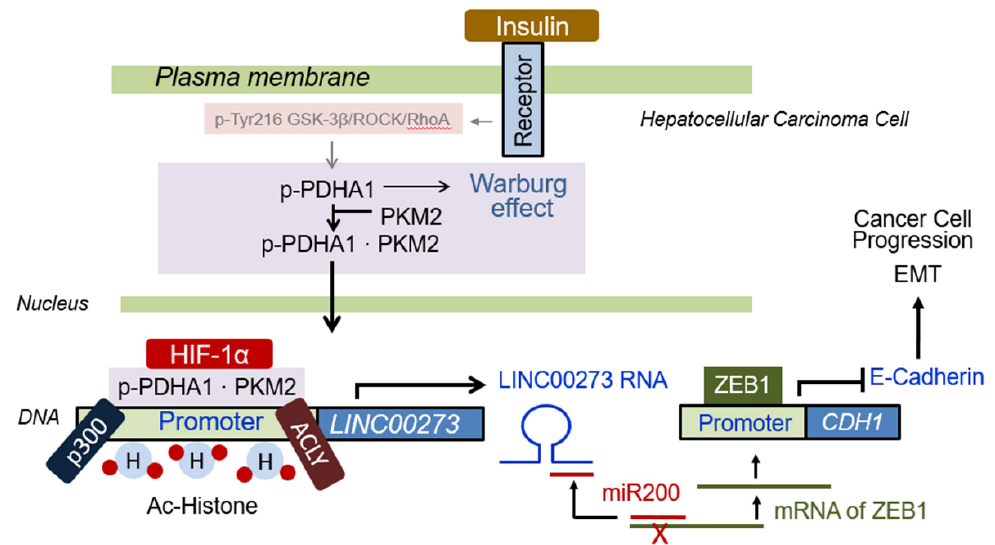
Figure 7. Proposed schematic for the role of p − PDHA1/PKM2 complex in cancer cells. Insulin induces Ser264 phosphorylation of PDHA1. Then p-PDHA1/PKM2 complex translocate into the nucleus, where the complex regulates histone acetylation by recruiting p300 HAT and ACL to